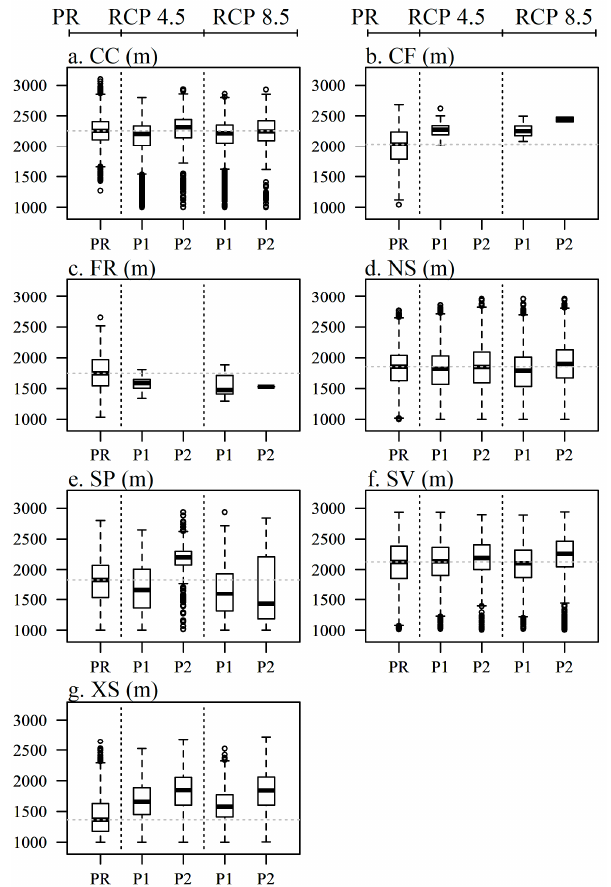
Figure 3. Changes in altitude as reported by the modeling ensemble for each of the seven single macro-types calculated over multiple years for two climate scenarios (RCP 4.5 and RCP 8.5) and time-slices (P1 = 2011–2040 and P2 = 2041–2070, respectively) compared to the present (PR = 1970–2000). Black lines show the median of the altitude calculated by the modeling ensemble, while the dotted line represents the median of the altitude for the present along the scenarios. Boxes delimit the 25th and 75th percentiles. Whiskers are 10th and 90th percentiles.